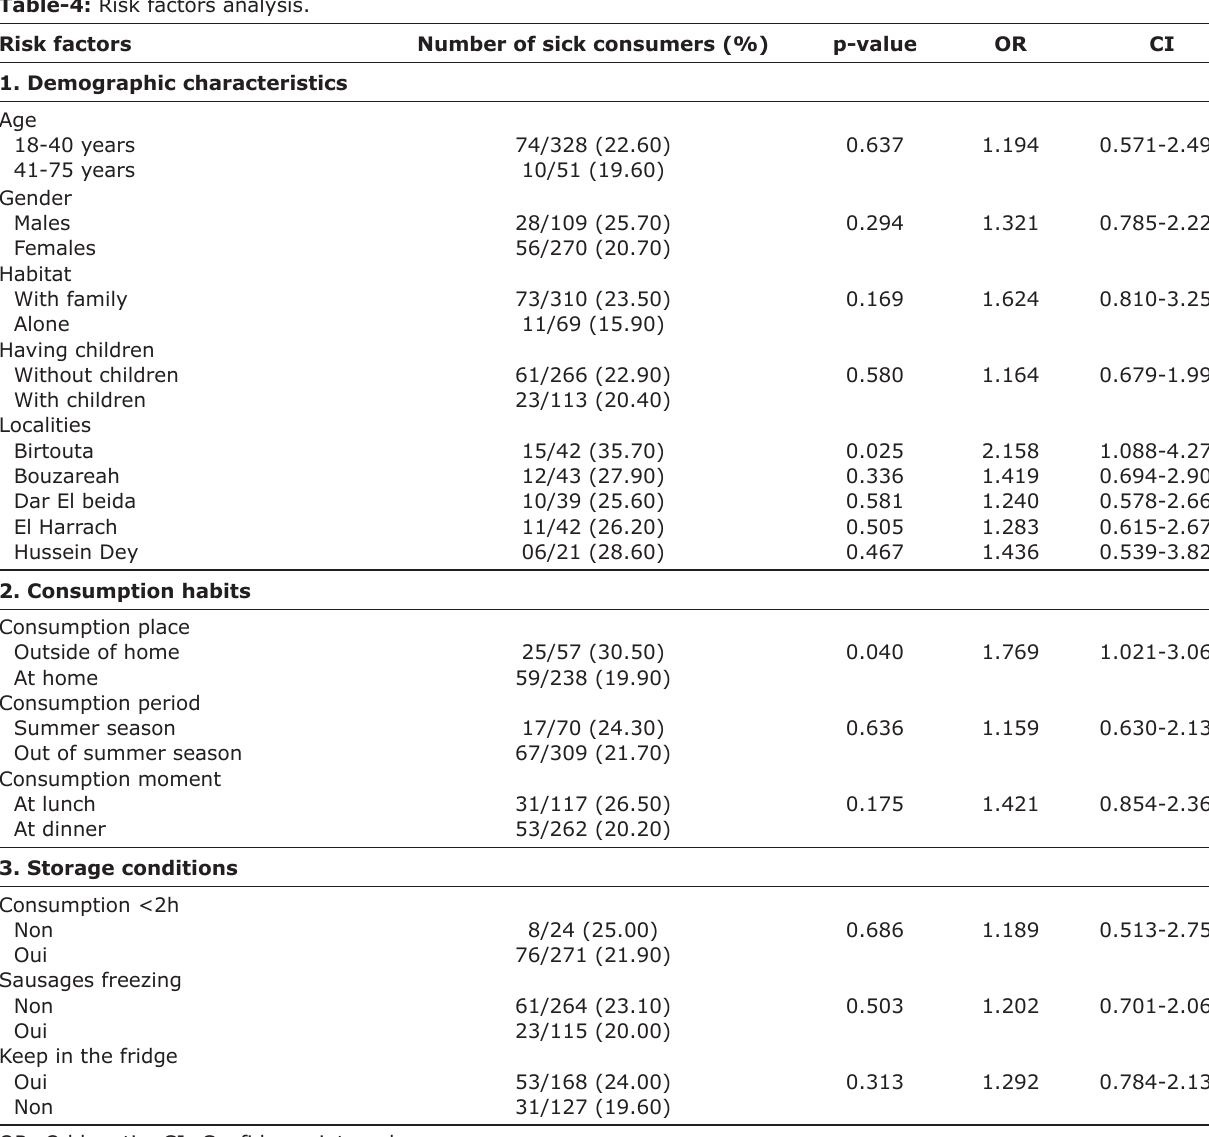
Table-4: Risk factors